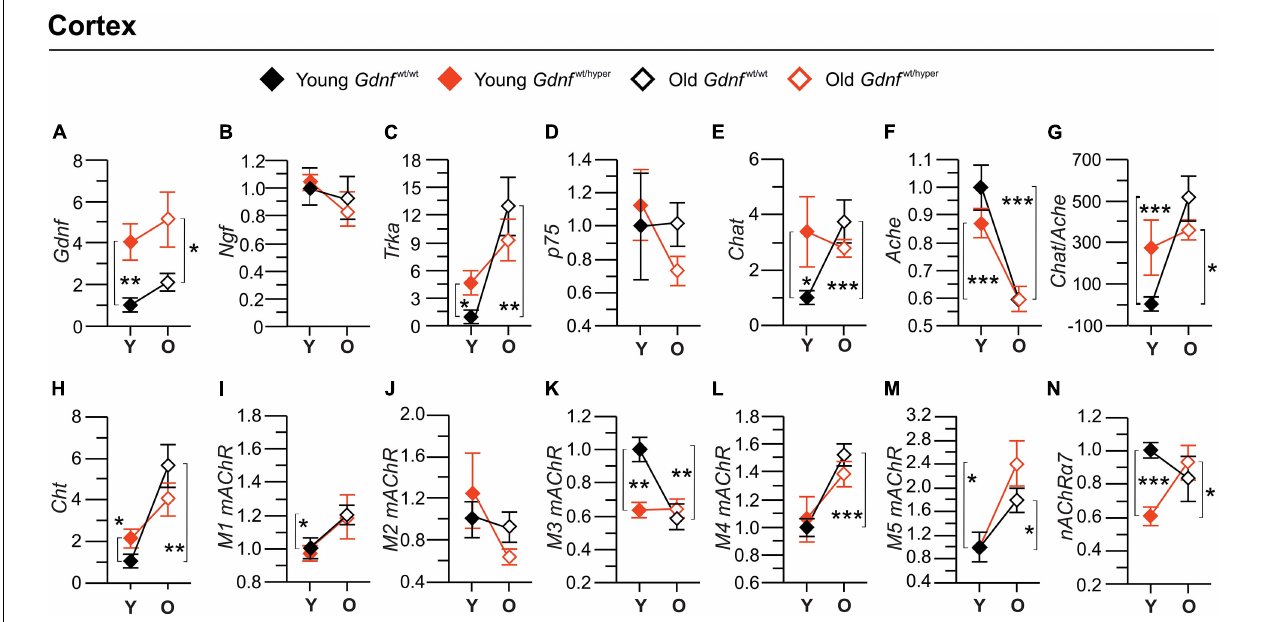
FIGURE 3 | Gene expression of the main cholinergic genes in the cortex. Graphs (A–F,H–N) show the fold-changes in the gene expressions relative to the corresponding gene expression level in the cortex of the young Gdnf wt / wt mice. The gene expressions were measured by quantitative PCR. Graph (G) shows percent changes in a Cholinergic index calculated based on the ratio between the gene expressions of Chat to Ache . n = 6 (young Gdnf wt / wt ), n = 5 (old Gdnf wt / wt ), n = 7 (young Gdnf wt / hyper ), n = 6 (old Gdnf wt / hyper ). Data are presented as mean fold changes ± SEM. * p < 0.05; ** p < 0.01; *** p < 0.001. Ache , acetylcholinesterase; Chat , choline acetyltransferase; Cht , choline transporter; Gdnf , glial cell line-derived neurotrophic factor; M1 mAChR, m1 muscarinic ACh receptor; M2 , m2 muscarinic ACh receptor; M3 mAChR, m3 muscarinic ACh receptor; M4 , m4 muscarinic ACh receptor; M5 , m5 muscarinic ACh receptor; p75, p75 neurotrophin receptor; α 7-nAChR , alpha 7 nicotinic ACh receptor; Ngf , nerve growth factor; O, old; Trka , tropomyosin receptor kinase A; Y,